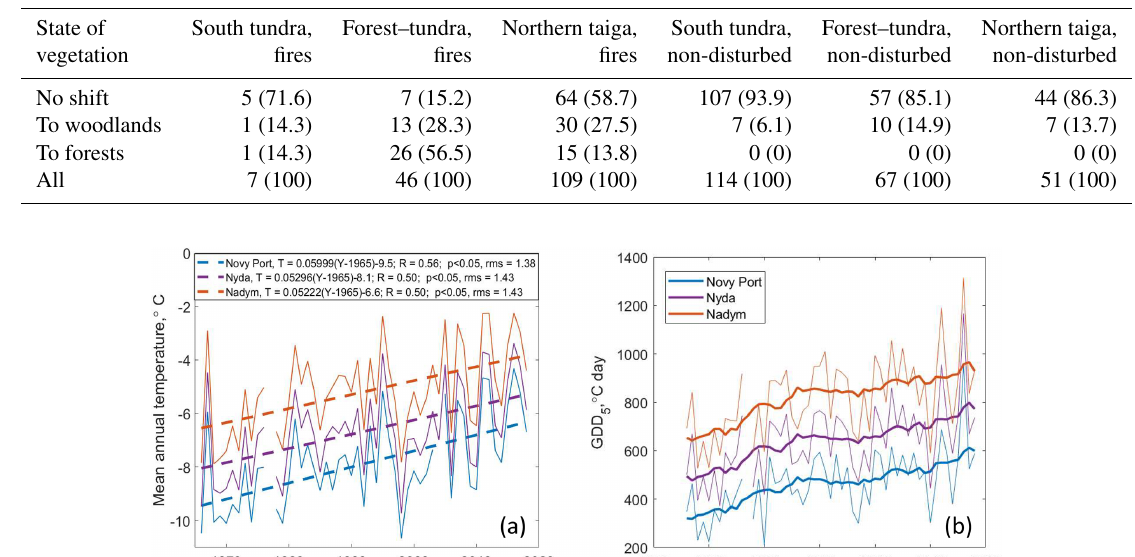
Table 7. Number of checkpoints (percentage of all checkpoints within a vegetation class, %) corresponding to vegetation shift in fire-affected and non-disturbed dry tundra.